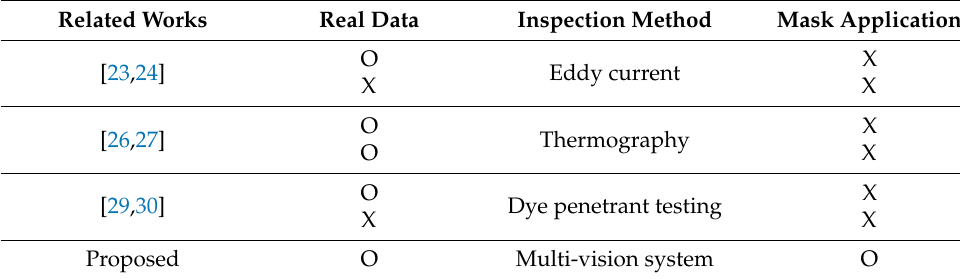
Figure 2. Image processing in multi-vision system. Table 1. Related works using inspection method.